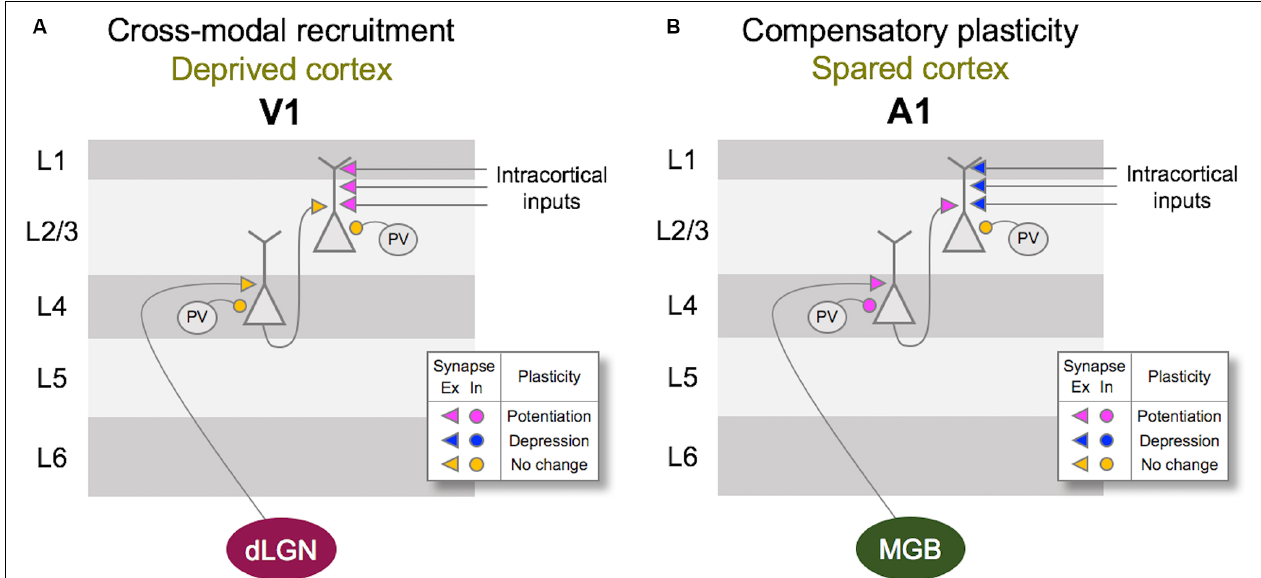
FIGURE 2 | Vision loss triggers cross-modal recruitment and compensatory plasticity across primary sensory cortices. (A) Summary of synaptic plasticity observed in V1 following the loss of vision. Synaptic connections that are examined are shown color-coded for potentiation (magenta), depression (dark blue), and no change (yellow) in synaptic strength. Excitatory (Ex) synapses are shown as arrowheads and inhibition (In) synapses are shown as circles. Vision loss does not alter the strength of excitatory feedforward connections from dLGN to Layer 4 (L4) or L4 to L2/3. There is no change in the inhibitory synaptic strength from PV interneurons to L4 or L2/3 principal neurons. In contrast, intracortical synapses onto L2/3 principal neurons potentiate. Based on the fact that L2/3 principal neurons receive multisensory information through long-range intracortical inputs, such adaptation is expected to allow cross-modal recruitment of V1 in the absence of vision. (B) Summary of synaptic plasticity observed in the spared A1. Feedforward excitatory synapses from MGBv to L4 as well as L4 to L2/3 potentiate following a week of visual deprivation. This is accompanied by a potentiation of PV inhibition to L4 principal neurons, but not to L2/3 principal neurons. In addition, intracortical excitatory synapses onto L2/3 principal neurons depress. Such synaptic changes are predicted to favor feedforward processing of information at the expense of intracortical influences, and may underlie lowered auditory threshold and refined frequency tuning of A1 L4 neurons following visual deprivation (Petrus et al.,